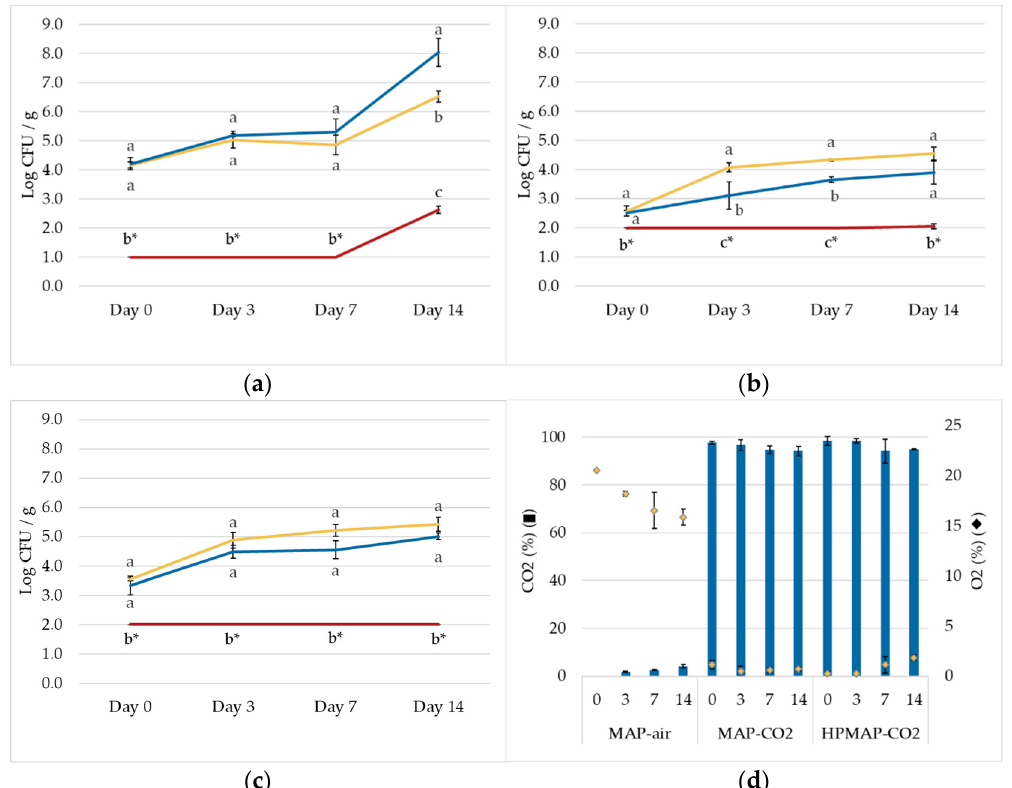
Figure 3. Fresh-cut carrot microbial levels of total mesophiles ( a ), yeasts and molds ( b ), and total coliforms ( c ), and gas composition ( d ), in the control packaged in air (MAP-air) ( ), control packaged in CO 2 (MAP-CO 2 ) ( ), and the treated packaged in CO 2 (HPMAP-CO 2 ) ( ), during a shelf-life trial at 4 °C. Treatment conditions were 120 bar — 40 °C — 20 min. Points with different small letters at the same time point represent significantly different values ( p < 0.05). * ND — Not detected. No colonies were found at the lowest dilution possible (< 1.0 log CFU/g).